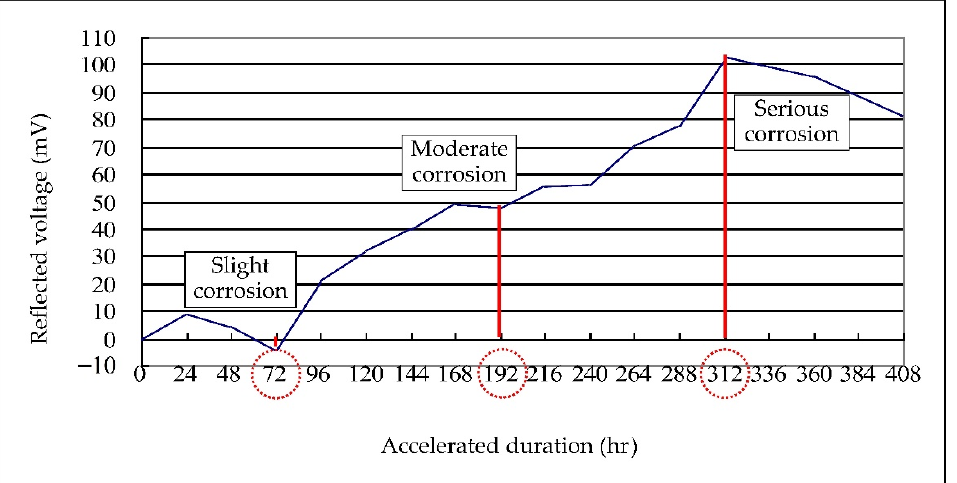
Figure 16. Reflected Voltage of 9 cm Protective Layer.